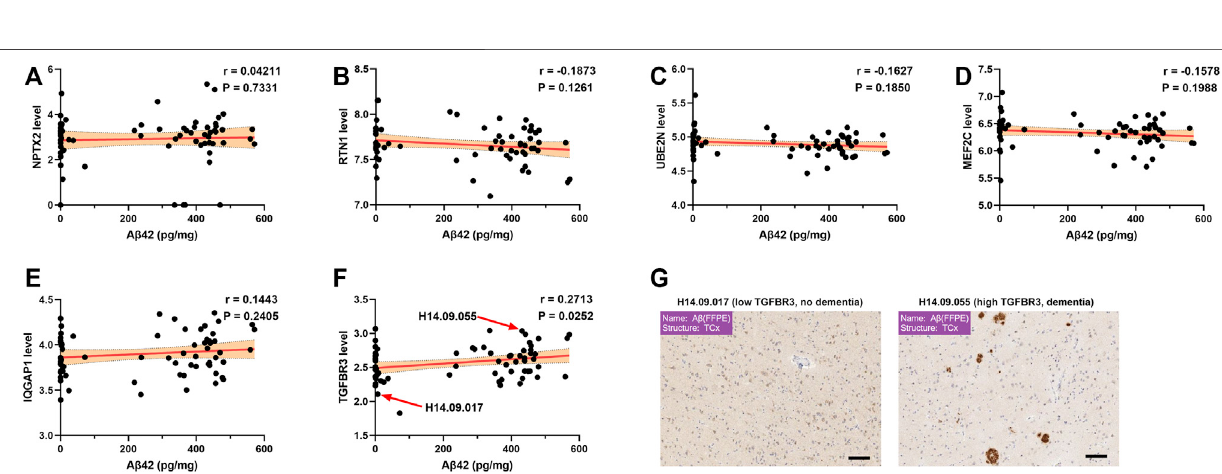
Frontiers in Cell and Developmental Biology |